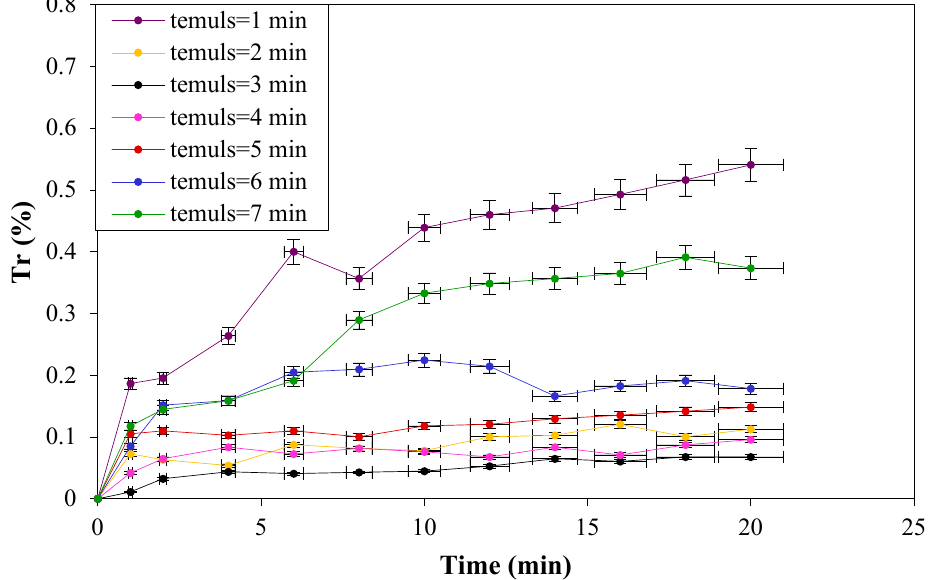
Figure 5. Effect of the emulsification time on emulsion stability (CSpan 80: 2% wt./wt., w: 250 rpm, int/org ( v / v ): 1/1, emu/ext ( v / v ): 0.15/1, t emuls = [1–7] min, [HNO 3Internal phase ]: 0.5M).